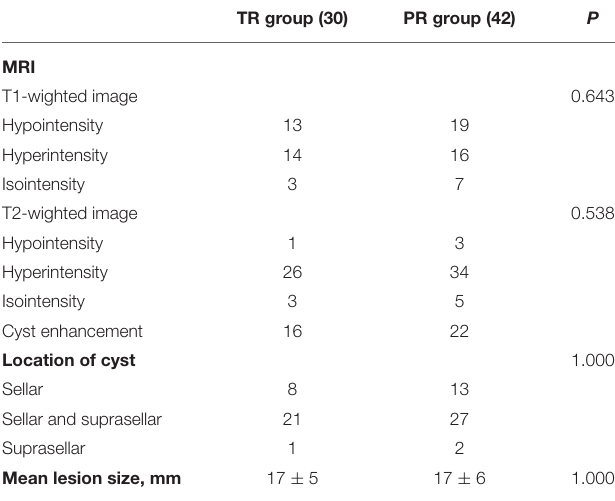
TABLE 4 | Cyst content and histopathological features of 72 Patients with